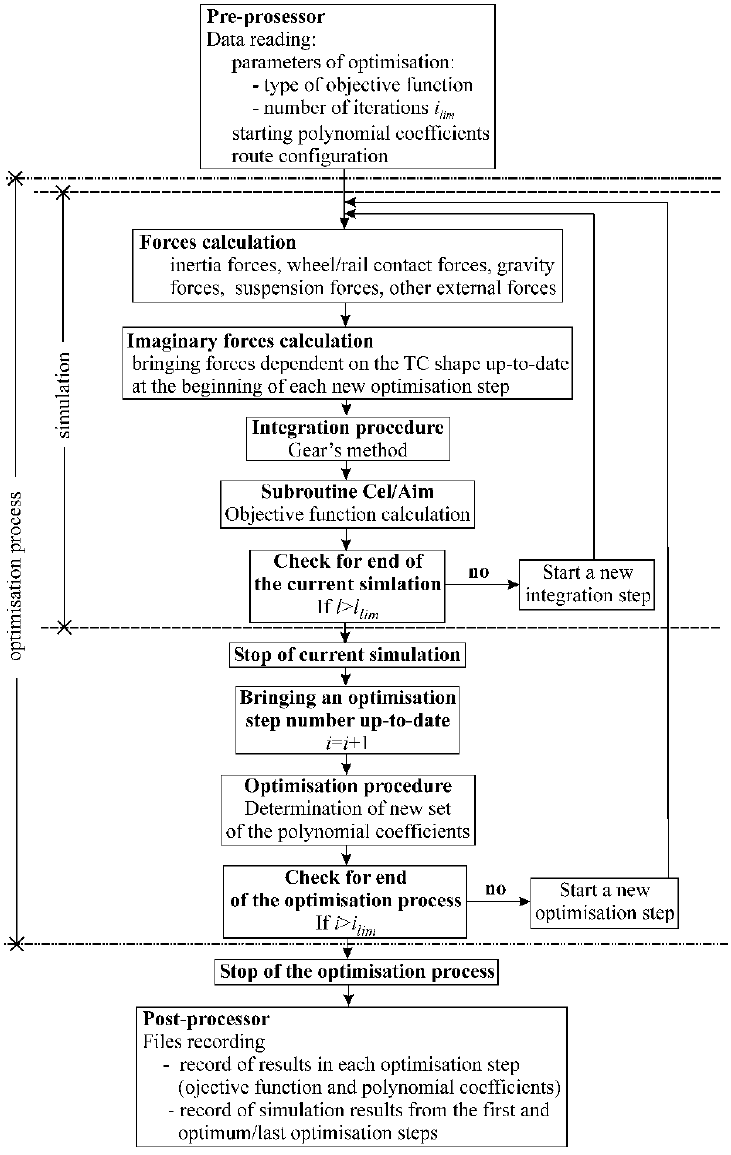
Figure 4. The scheme of software.